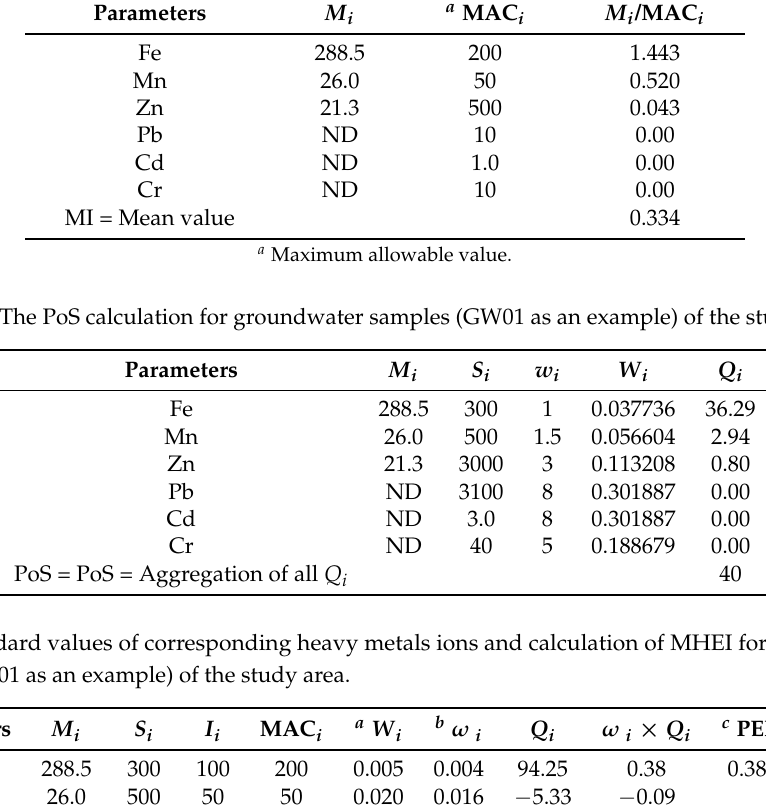
Table 5. The MI calculation for groundwater samples (GW01 as an example) of the study area. Parameters